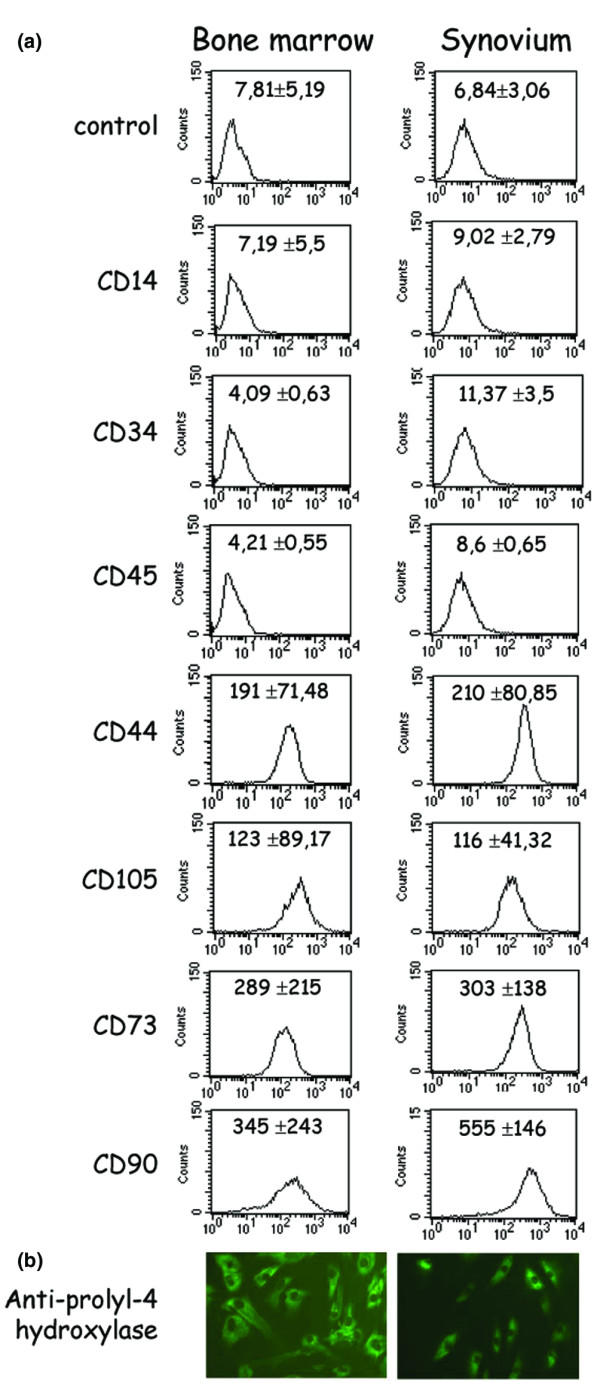
Immunophenotype of bone marrow-derived (left) and synovium-derived adherent cells (right). (a) Fluorescence-activated cell sorting of CD marker expression. Results are expressed as the mean fluorescence intensity ± standard error of the mean. One representative experiment out of six different samples of bone marrow mesenchymal stem cells (three normal, two osteoarthritis and one rheumatoid arthritis) and synovium mesenchymal stem cells (two rheumatoid arthritis, two osteoarthritis and two healthy) is shown. Control corresponds to the fluorescence due to the isotypic control. (b) Immunofluorescence staining on cells in a monolayer using the monoclonal antibody specific for human prolyl-4-hydroxylase.